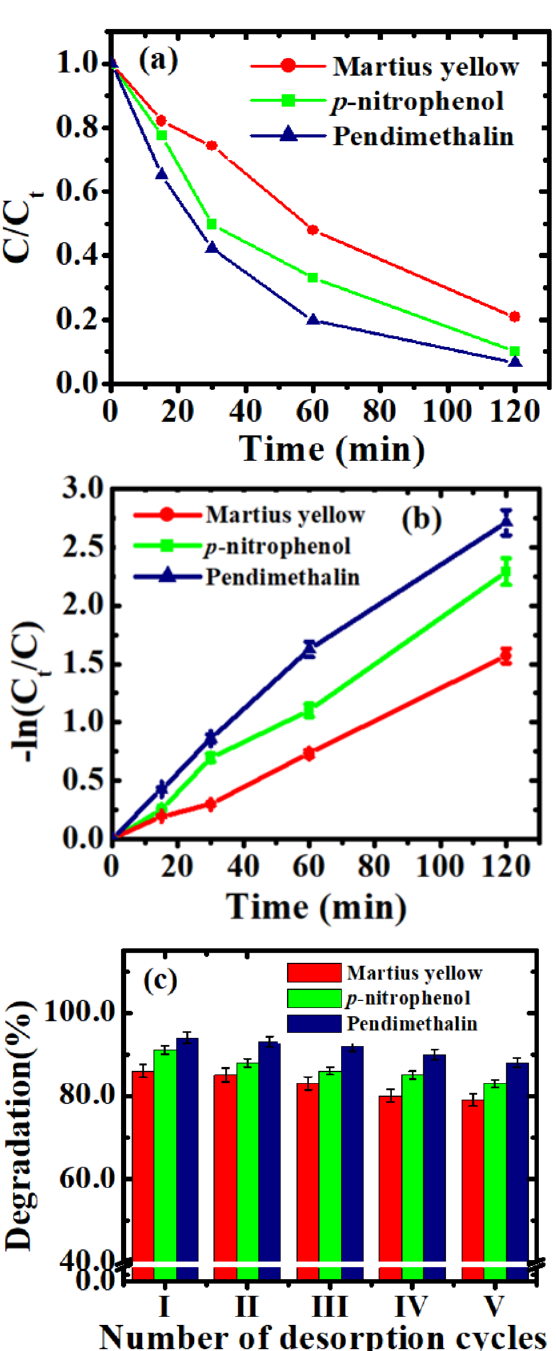
Figure 10. ( a ) Effect of irradiation time, ( b ) Langmuir – Hinshelwood kinetic plots on photodegradation of nitroaromatic pollutants using Sr 0.4 Ti 0.6 Fe 2 O 4.6 NPs and ( c ) desorption studies of p -nitrophenol, pendimethalin and Martius yellow (experimental conditions: pH, 3.0; temperature, 25.0 ± 1 °C; irradiation time, 2.0 h; catalyst dose, 0.2 g/L ( p -nitrophenol and pendimethalin and 0.4 g/L (Martius yellow))). Table 5. Values of apparent rate constant and regression coefficient values for nitroaromatic com-